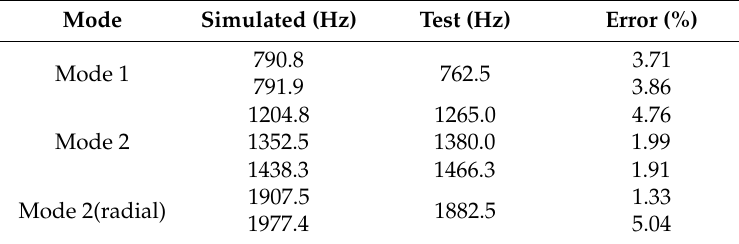
Figure 10. Frequency-response waveforms of whole motor. ( a ) Frequency-response amplitude waveform; ( b ) Frequency-response amplitude waveform (real part); ( c ) Frequency-response amplitude waveform (imaginary part). Table 5. Comparison of simulated results and test results of motor